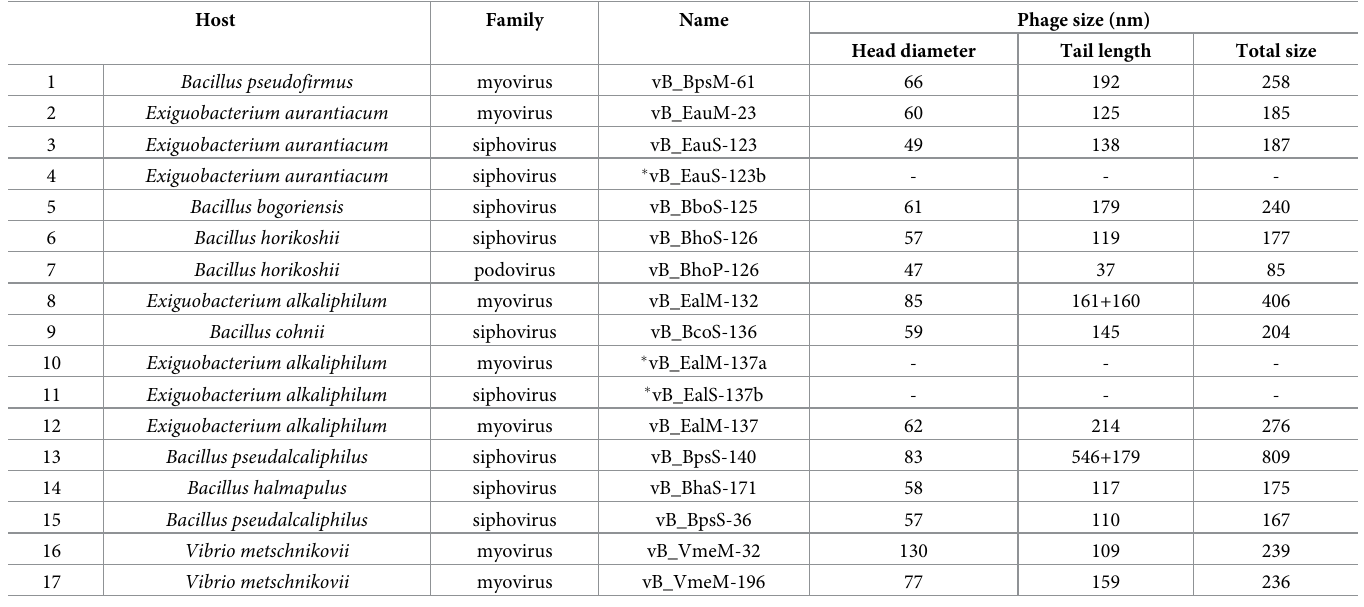
Table 2. Bacteriophage morphology and naming. Structural characterization, classification and naming of phages isolated from Lake